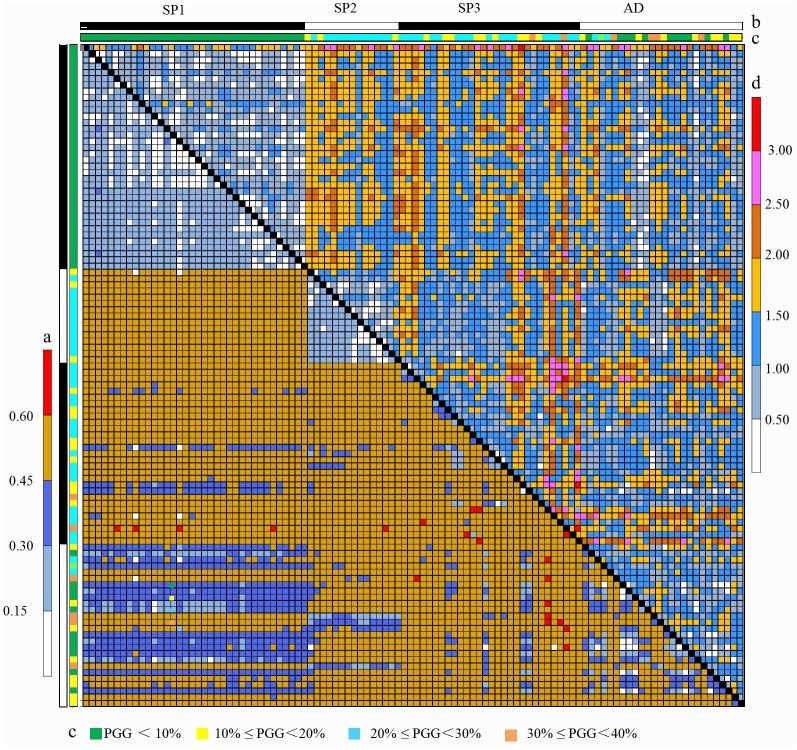
Comparison of two matrixes of pairwise DIST distances between ILs based on AFLP markers and phenotypic traits.Lower left (a): Matrix of pairwise DIST distances between ILs based on AFLP markers; (b): The structure of the IL population; Upper right (c): The PGG in ILs; (d): Matrix of pairwise DIST distances between ILs based on phenotypic traits.